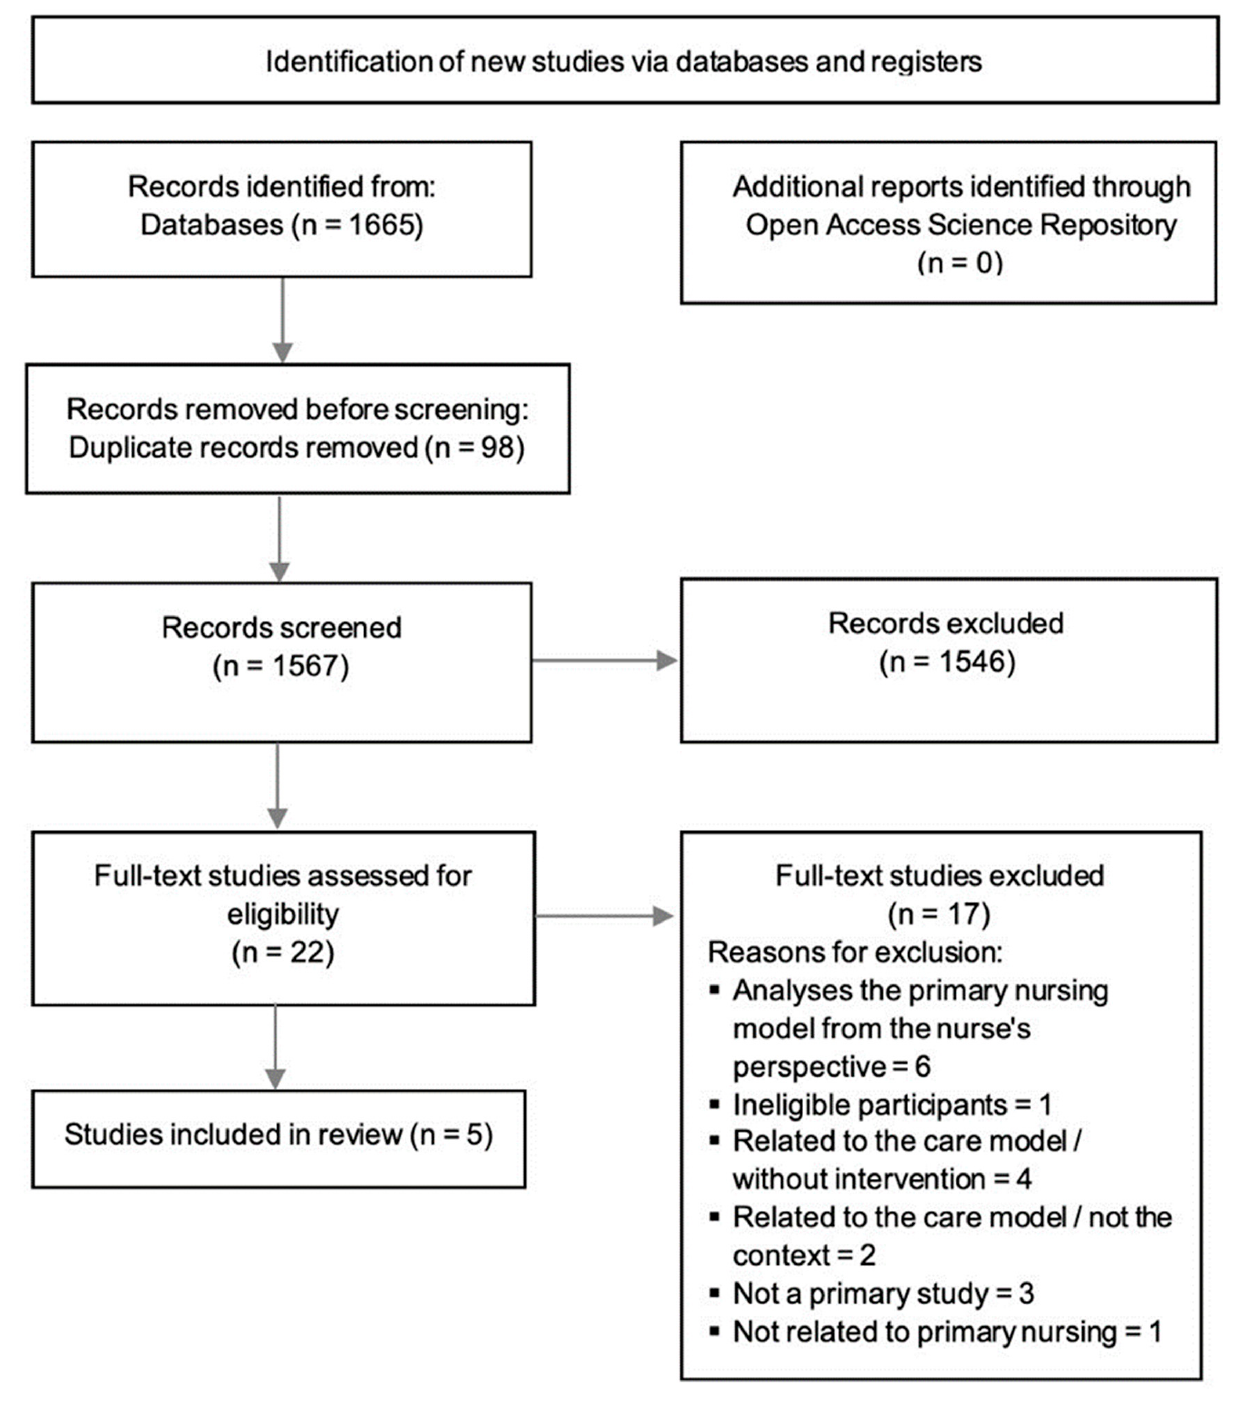
Figure 1. PRISMA diagram flow.